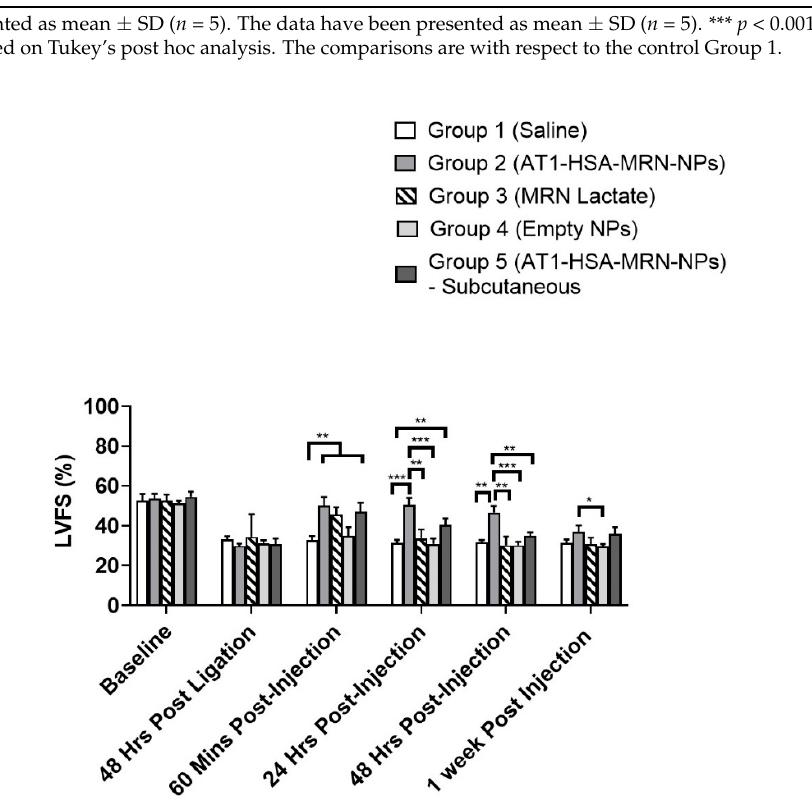
Figure 9. Milrinone levels detected in plasma 24 h post treatment for Groups 2, 3, and 5. The graph shows a representative result of mean ± SD ( n = 3). *** p < 0.001 was considered significant based on Tukey’s post hoc analysis. 2.10. Safety and Toxicity of the AT1-HSA-MRN-NPs The serum samples collected from the animals were analyzed for markers of safety and toxicity. The liver function and toxicity analysis were performed by analyzing alka- line phosphatase (ALP), aspartate aminotransferase (AST), and alkaline aminotransferase